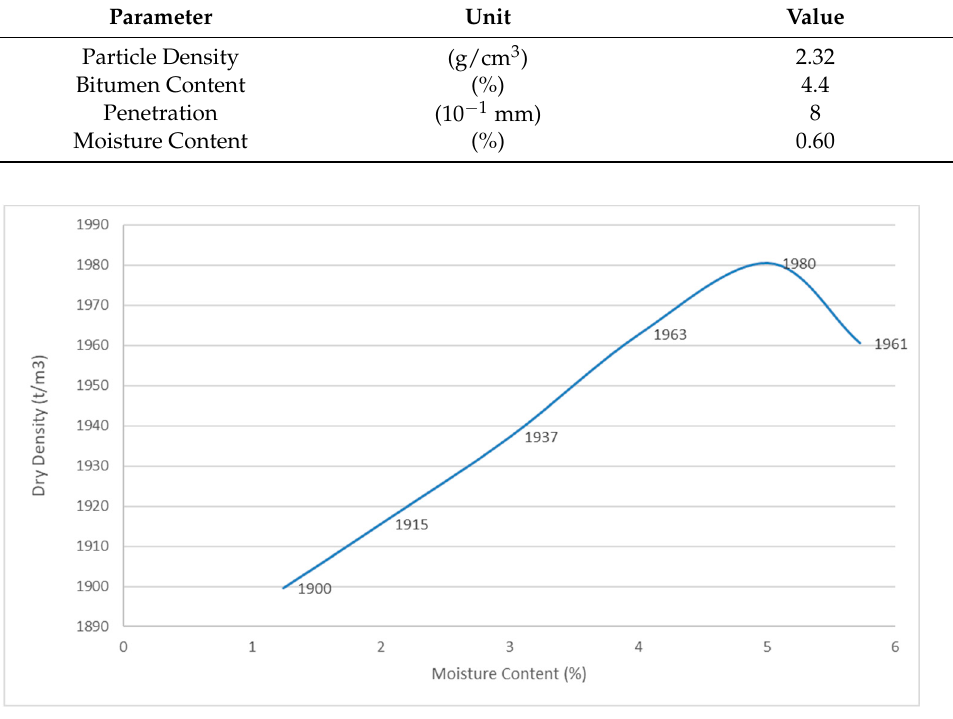
Figure 1. Results of the optimum moisture content (OMC) test. Table 1. RAP particle size distribution test.